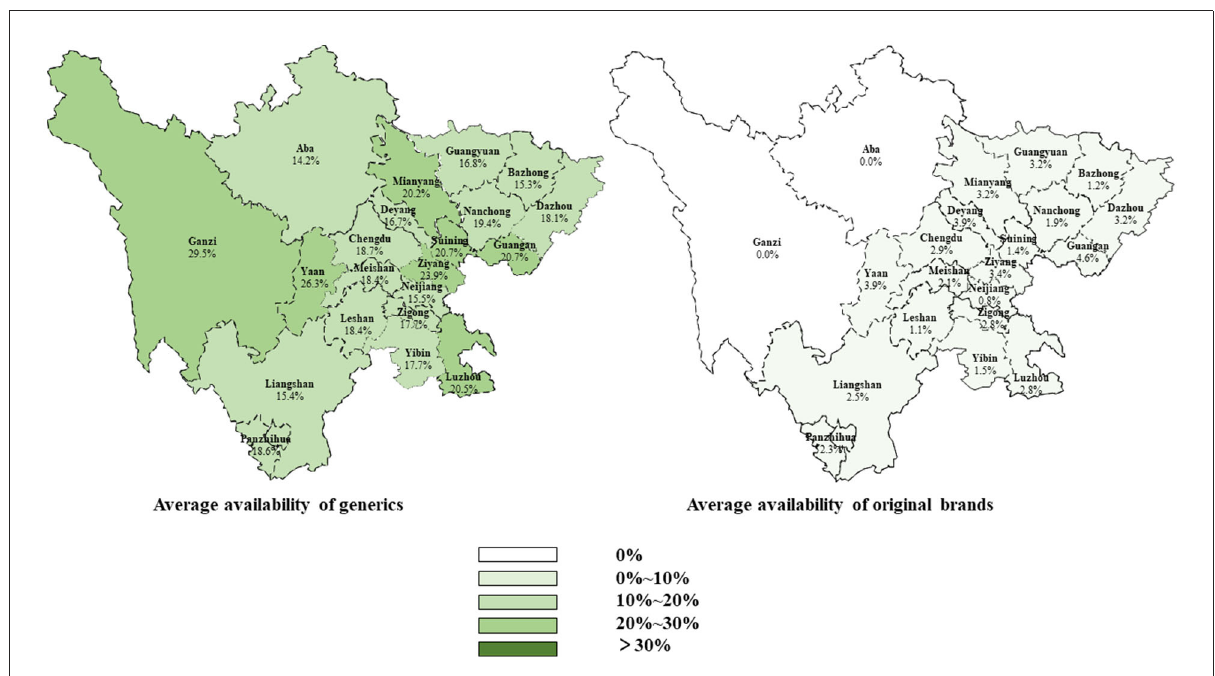
FIGURE1 Average availability of originator brands and generics in different cities of Sichuan Province.